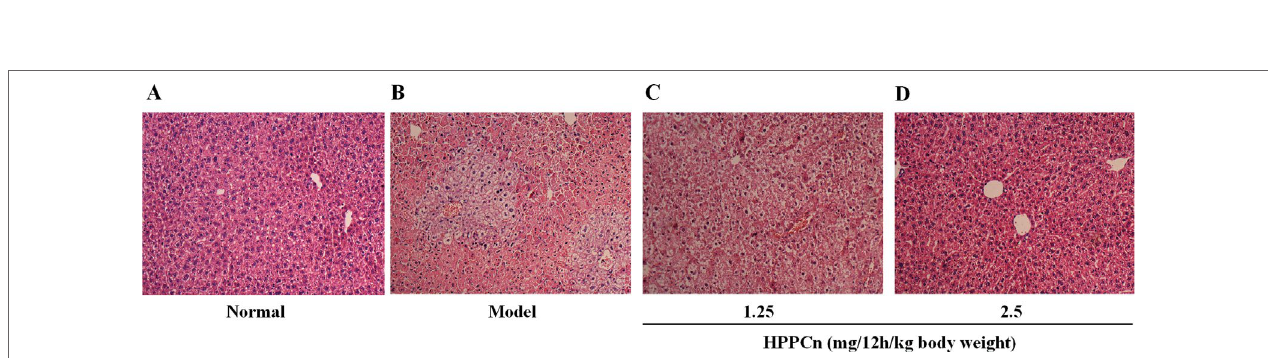
FIGURE 6 | rhHPPCn reduced the acute liver injury detected by HE staining. (A) Control normal mice. (B) Acute liver injury model mice. (C) Acute liver injury model mice treated with rhHPPCn at 1.25 mg/12 h/kg body weight for 24 h. (D) Acute liver injury model mice treated with rhHPPCn at 2.5 mg/12 h/kg body weight for 24